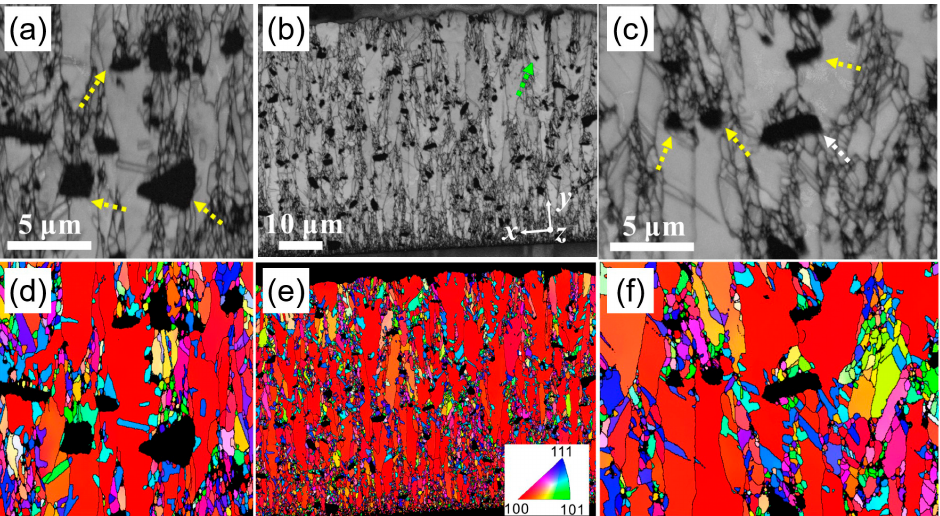
Figure 6. ( a – c ) EBSD band contrast maps of Ni-SiC composite coating; ( a , c ) enlarged images of ( b ); ( d – f ) corresponding crystal orientation maps. The colorful arrows in the figures represent the co-deposited SiC particles.